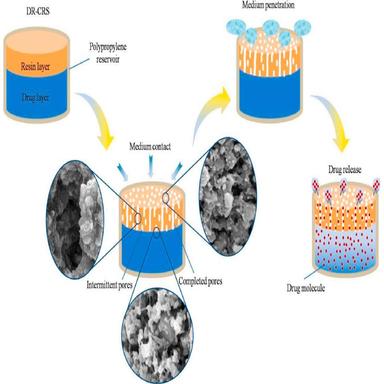
Schematic diagram of drug release from DR-CRS. The drug was incorporated into the core and coated with a resin layer containing pore formers that allowed the medium to penetrate into the core. Drug and fillers were then dissolved and an osmotic pressure was established within the system to force the drug diffusion through the pores and channels formed in the resin layer.